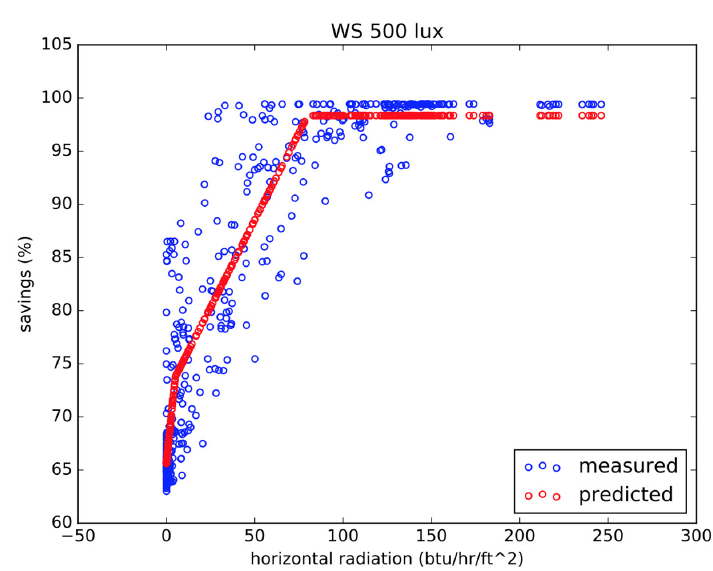
Figure 9. Plot of energy savings test data for the 500 lux setpoint test configuration (WS 500 lux) as a function of measured external horizontal radiation (blue), and predicted savings (red) from our piecewise regression model.